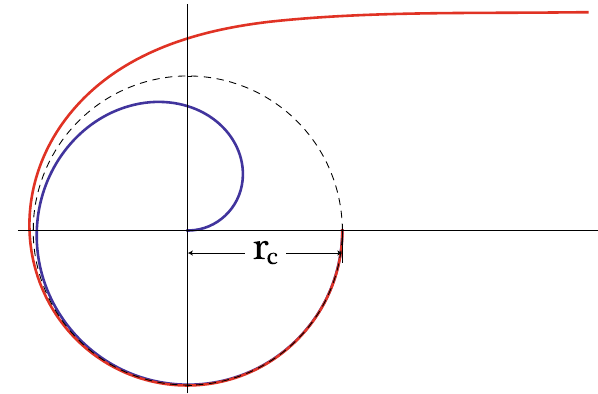
Fig. 3 Critical trajectories of photons with b = b c . Orbits of the first and the second kinds are allowed for test particles that approach by spiraling to the unstable circular orbit at r = r